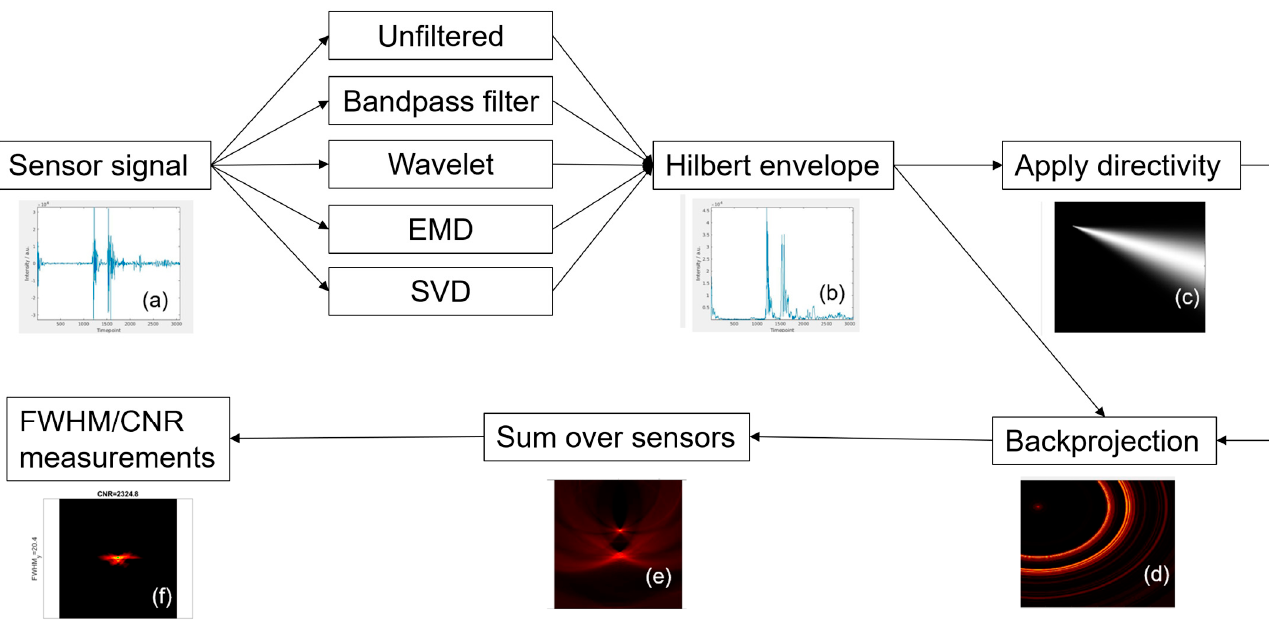
Figure 2. Example of a raw signal from the single sensor ( a ) followed by a Hilbert envelope ( b ). Angular intensity of optional directivity ( c ). Backprojection of a single sensor ( d ) followed by summing over all sensors ( e ). FWHM and CNR measurements ( f ).